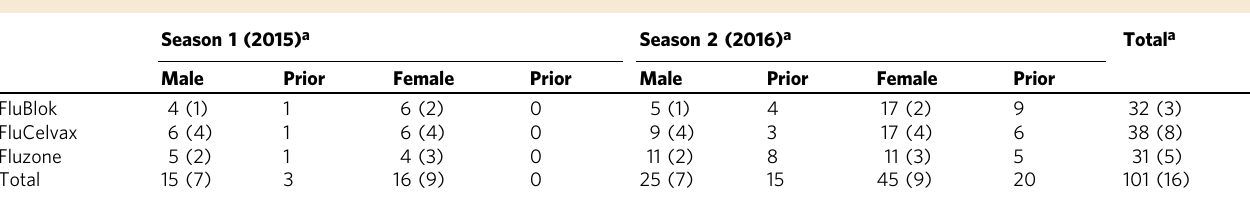
individuals are lower than after the fi rst-year post-vaccination, and for several of them are as low as the pre-vaccination antibody af fi nity in year 1. The loss of high-af fi nity antibodies was already apparent on Day 180 post-vaccination in the fi rst year of study (Fig. 4d, f). Surprisingly, following second-year vaccination, a decrease in antibody af fi nity maturation against the H1N1 HA1 domain was observed compared with fi rst year, with minimal change in antibody af fi nity measured for 11/16 of repeat vaccinated individuals (Fig. 4d, h). The same pattern was observed, irrespective of the vaccine platform, with more pronounced drop in af fi nity fold change observed for the FluBlok and the Fluzone vaccine recipients compared with FluCelvax (Fig. 4h). No or minimal af fi nity maturation of antibody binding to the H1N1pdm09 HA2 domain was measured following